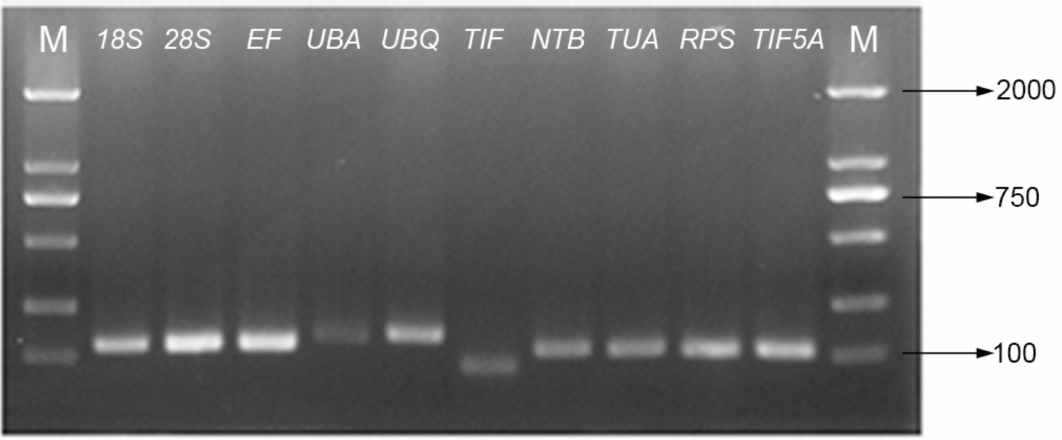
Figure 1. Agarose gel analysis of primers specificities in amplification of candidate